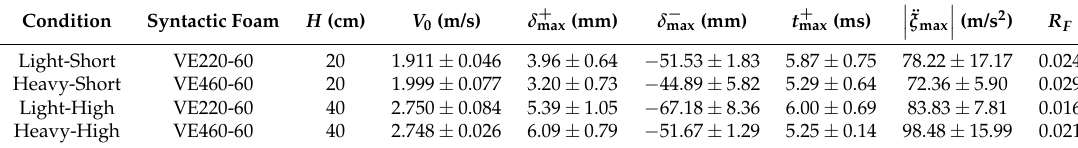
Table 1. Mean entry velocity V 0 ; maximum δ + max and minimum δ − max values of the tip deflection; t + max rise time to reach the maximum upward deflection δ + max ; maximum value of the acceleration ¨ ξ max ; and hydroelasticity factor R F along with standard deviations for the four experimental